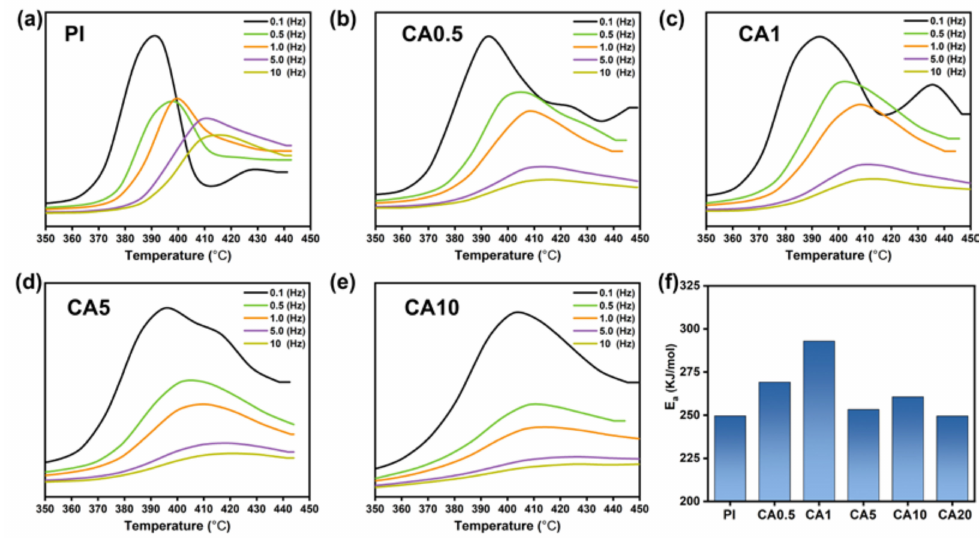
Figure 3. ( a – e ) tan( δ ) curves of CA/PI membranes monitored by DMA; ( f ) activation